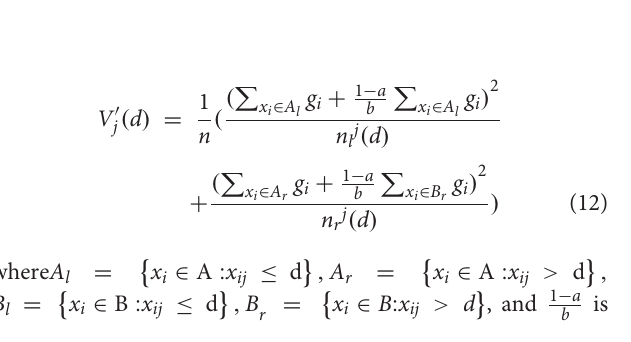
FIGURE 5 | Comparison of the top k ranks with different